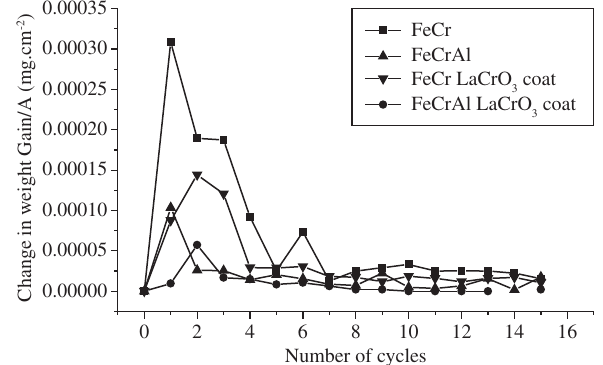
Figure 5. Cyclic oxidation curves of the coated and uncoated alloys. Each cycle consisted of 7 hours at 1000 °C followed by cooling to room tempera-